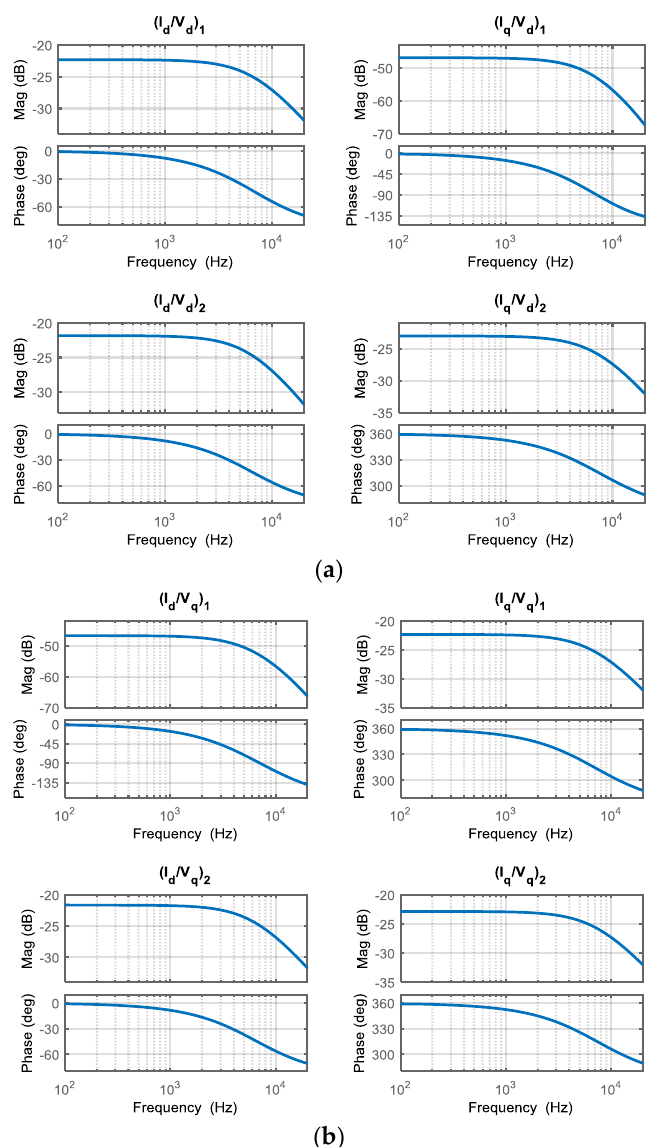
Figure 9. Frequency response parameters for the simulated RL network: ( a ) First set of independent perturbations ( 𝑀 1 ); ( b ) Second set of independent perturbations ( 𝑀 2 ).